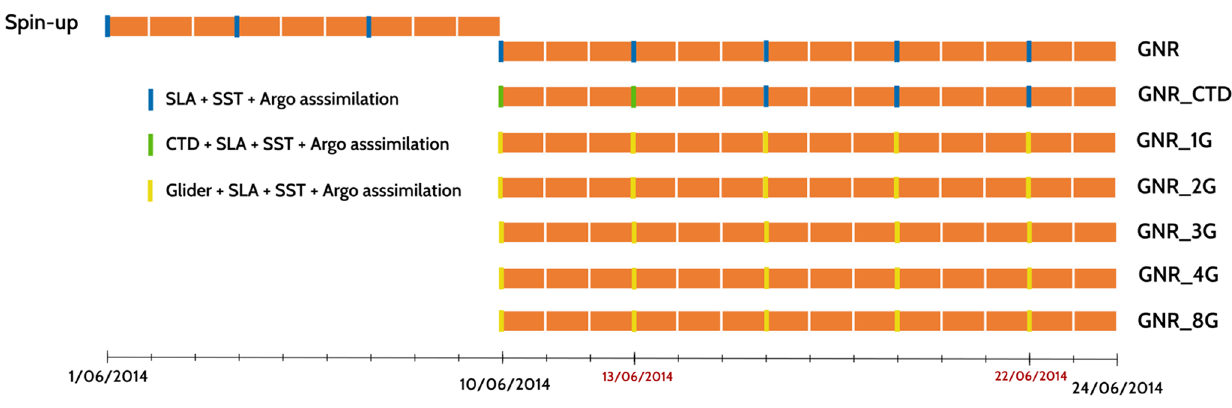
Figure 7. Timeline of the seven data-assimilative simulations. The analyses dates are highlighted in color, indicating the assimilated